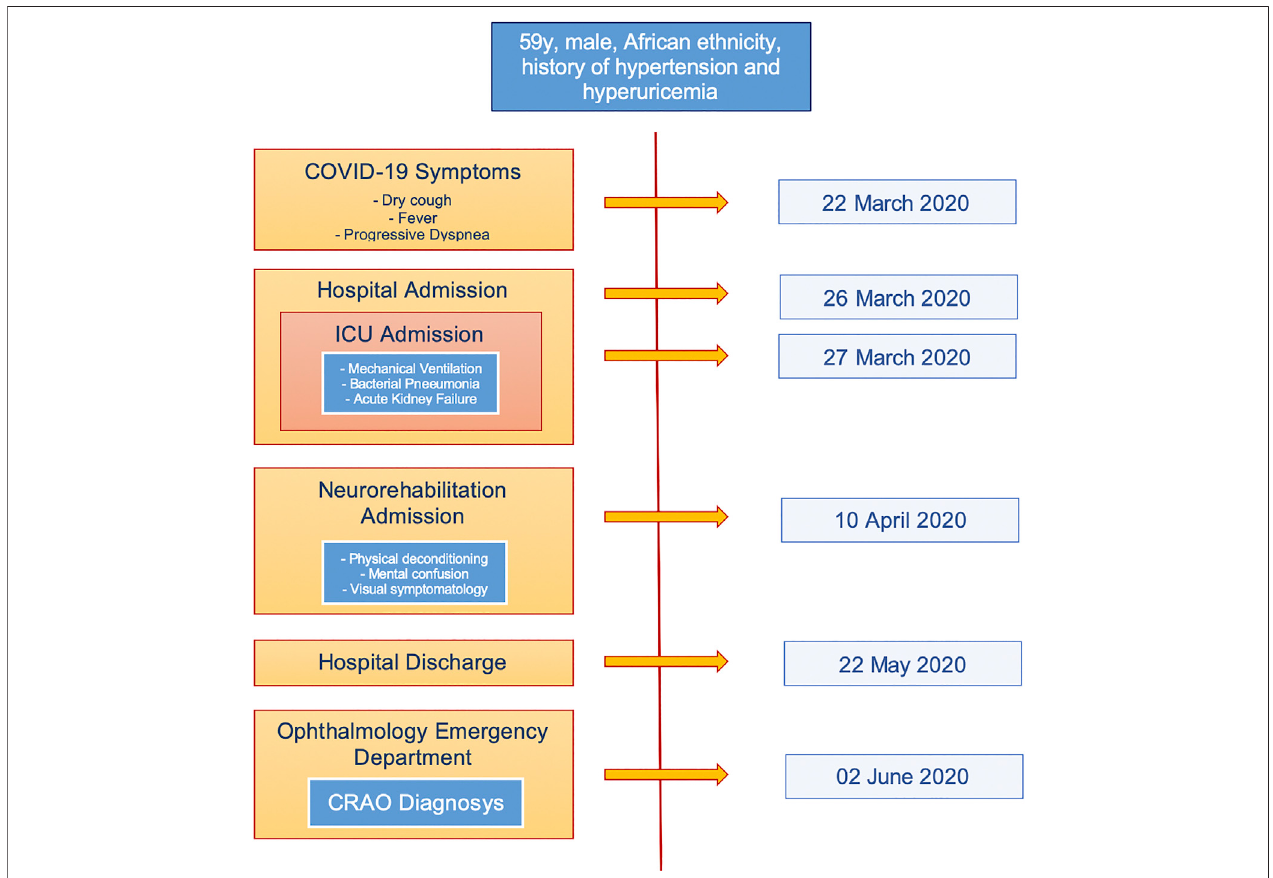
FIGURE 4 | Case report